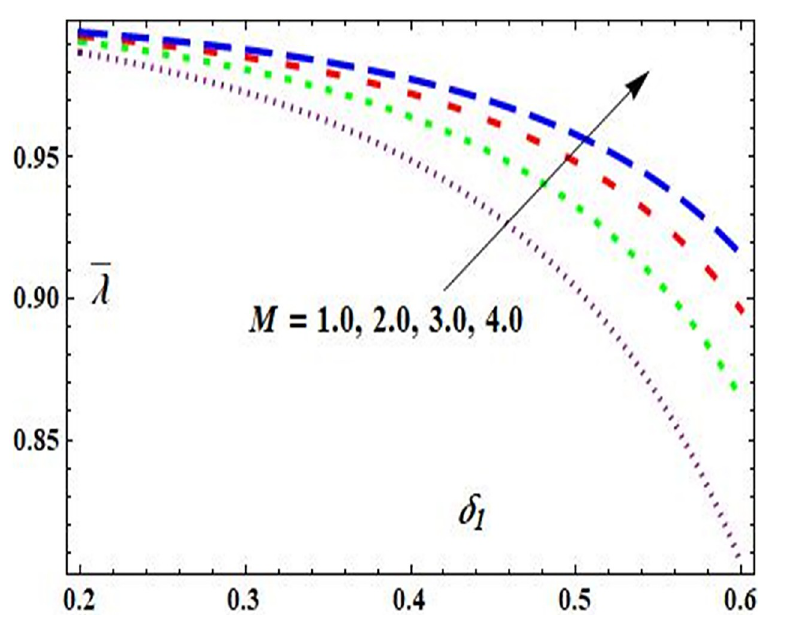
Fig 4. Plot of � λ on M & δ 1 with ϕ ¼ π